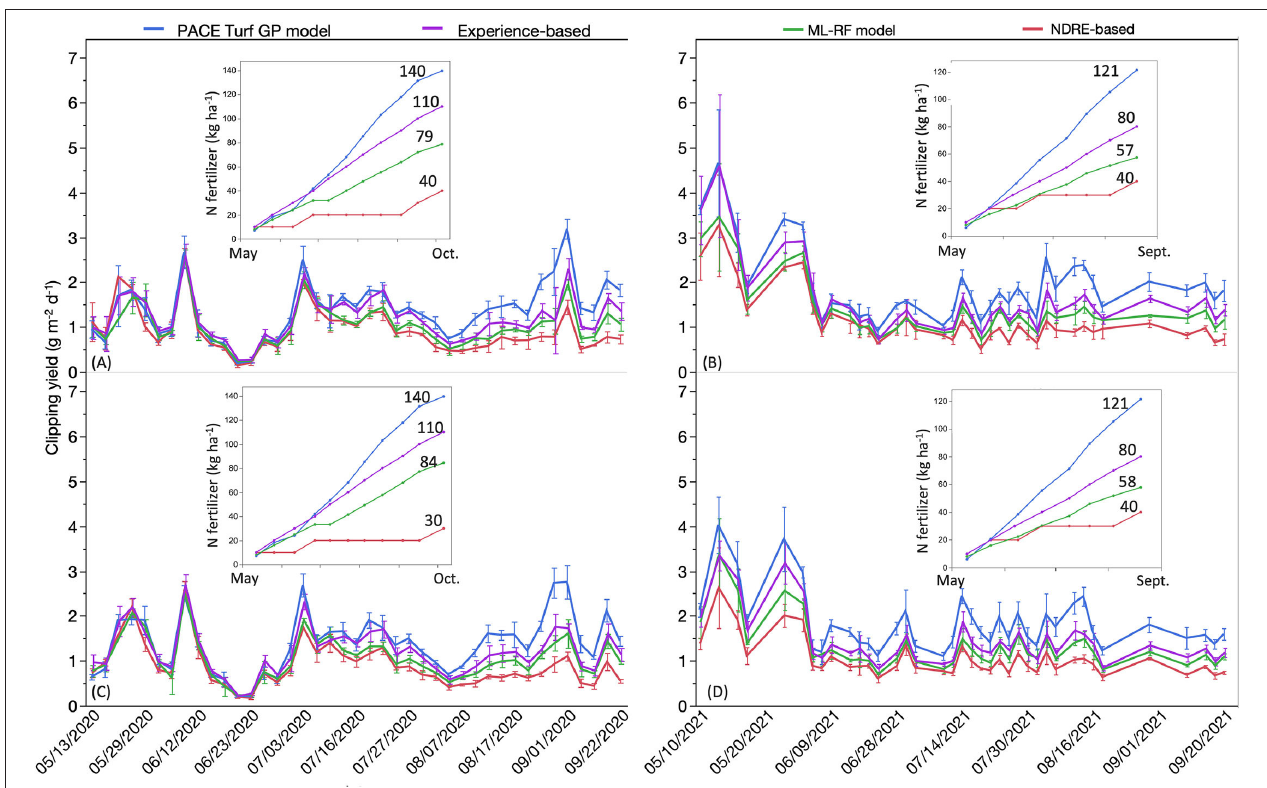
FIGURE 2 | Creeping bentgrass clipping yield response to four nitrogen (N) application strategies, which include PACE Turf growth potential (GP) model, traditional N fertilization plan (experience-based), machine learning-random forest (ML-RF) method, and vegetative index-based strategy (NDRE-based). (A) creeping bentgrass growth response on root zone A, data collected in 2020. (B) bentgrass growth response on root zone A, data collected in 2021. (C) bentgrass growth response on root zone B, data collected in 2020. (D) bentgrass growth response on root zone B, data collected in 2021. Inserted figures in each panel represent the cumulative N fertilizer usage for each year on each root zone. Error bars indicate standard